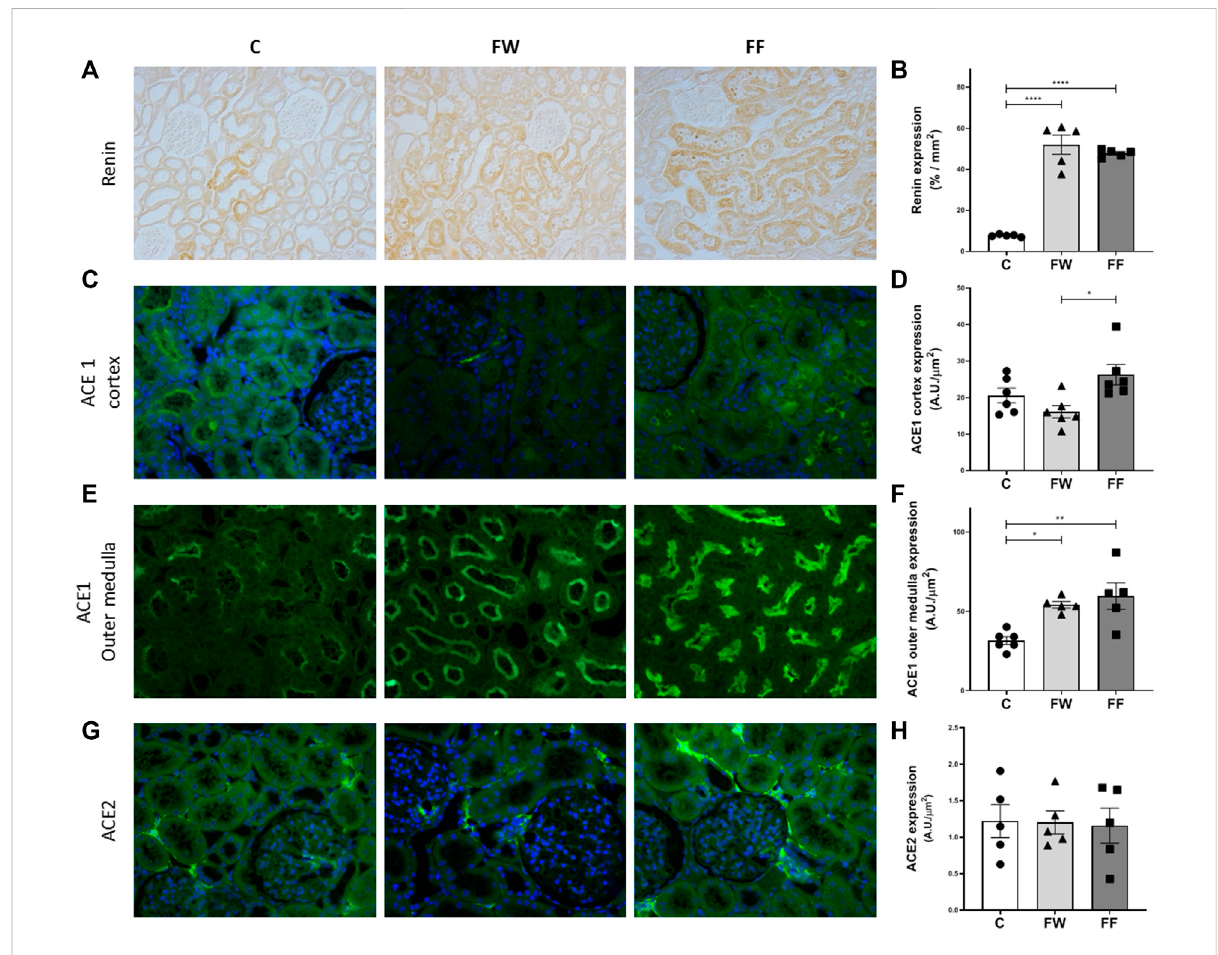
FIGURE 3 Renal expressions of renin, ACE1 and ACE2. Representative photomicrographs and quantitative analysis of the renin (A – B) (original magni fi cation ×200; by immunohistochemistry); ACE1 expression in the cortex (C – D) and outer medulla (E – F) ; and ACE2 (G – H) (original magni fi cation ×400; by immuno fl uorescence). Sign fi cance level: ANOVA followed by Bonferroni; values are means ± standard error, 5 – 6 animals per group. * p ≤ 0.05; ** p ≤ 0.01; *** p ≤ 0.001; **** p ≤